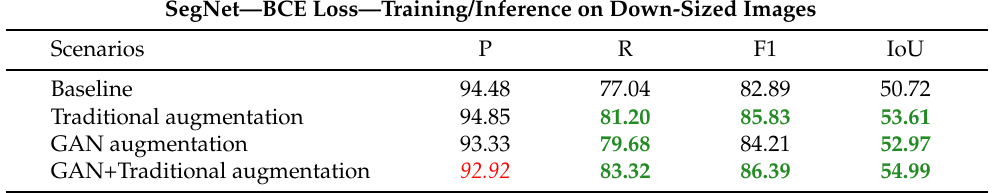
Table 7. SegNet performance, Experiment 1.